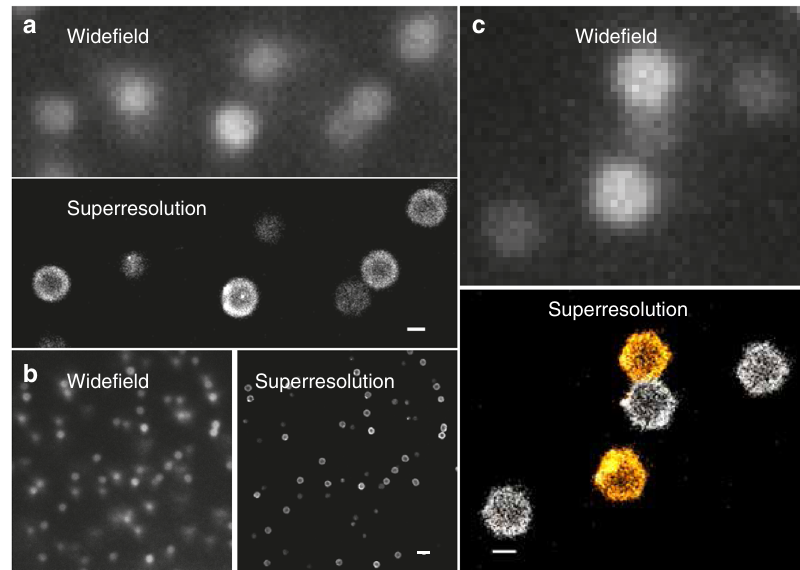
Fig. 1 Comparison of conventional wide fi eld and dSTORM superresolution images of densely packed microgels. a , b show images of Alexa Fluor ® 647 dye- labeled microgels seeded in a dense suspension ( ζ = 0.86, c = 10.8wt%). Images are taken in the bulk and thus some of the particles are out of focus and located deeper inside the sample, appearing less bright. This also affects the superresolution imaging leading to a reduced number of localized points that can be used for the reconstruction. c Wide fi eld and two-color dSTORM images of microgels at the glass-sample interface including a pair in contact ( ζ = 1.89, c = 23.6 wt%). The wide fi eld image was taken with a low pass fi lter for Alexa Fluor ® 647 and thus the microgel labeled with second dye CF680R is barely visible. The two-color image was reconstructed using the spectral demixing technique 37, 63 . Scale bar 500 nm in panel a and c and 2 μ m in panel